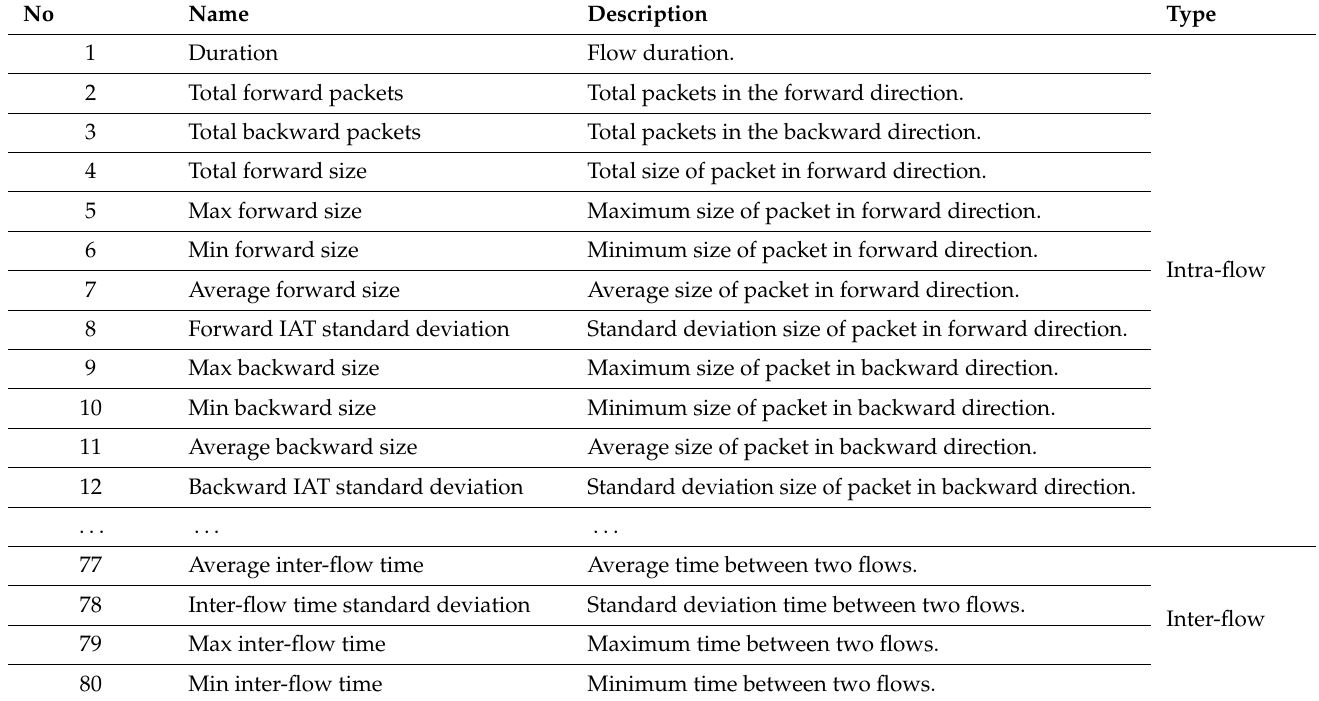
Table 3. Partial feature set generated by CICFlowMeter. IAT—inter-arrival